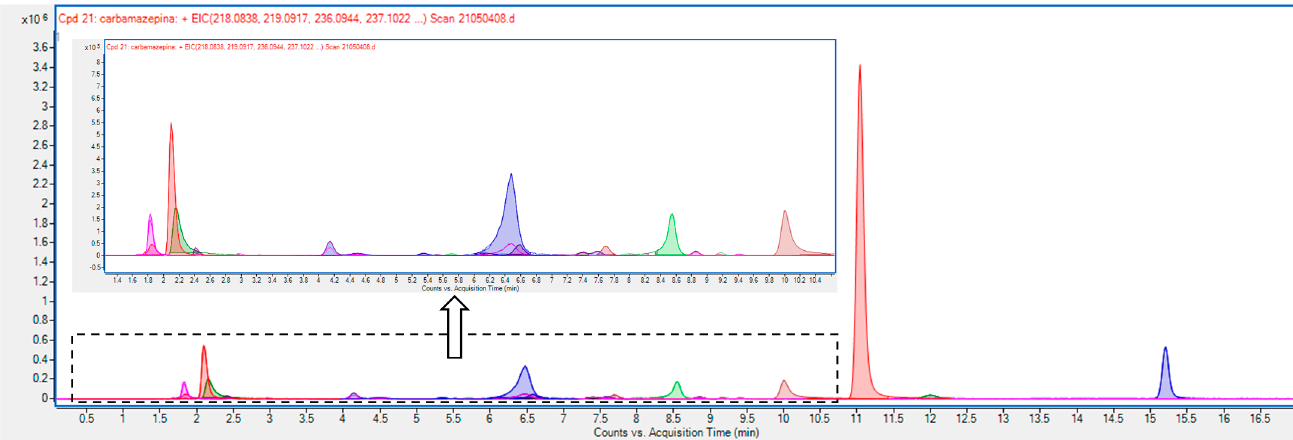
Figure 7. Chromatographic profile of a methanol blank (black line) and samples (red, blue, orange and green line).